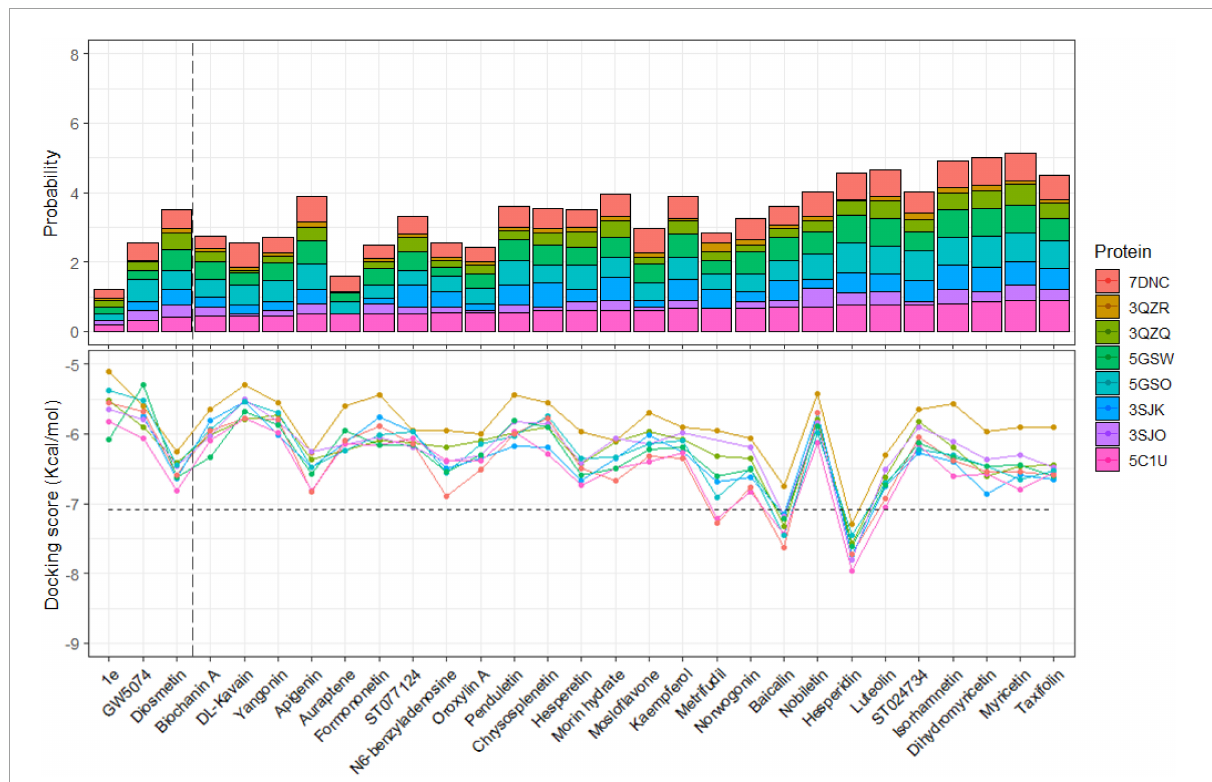
FIGURE7 Percentage (upper) and average of docking scores (lower) of models bound at active site of each 29 ligands to eight different proteins. The vertical and horizontal dashed lines are the thresholds of the probability and the average of docking scores, respectively.